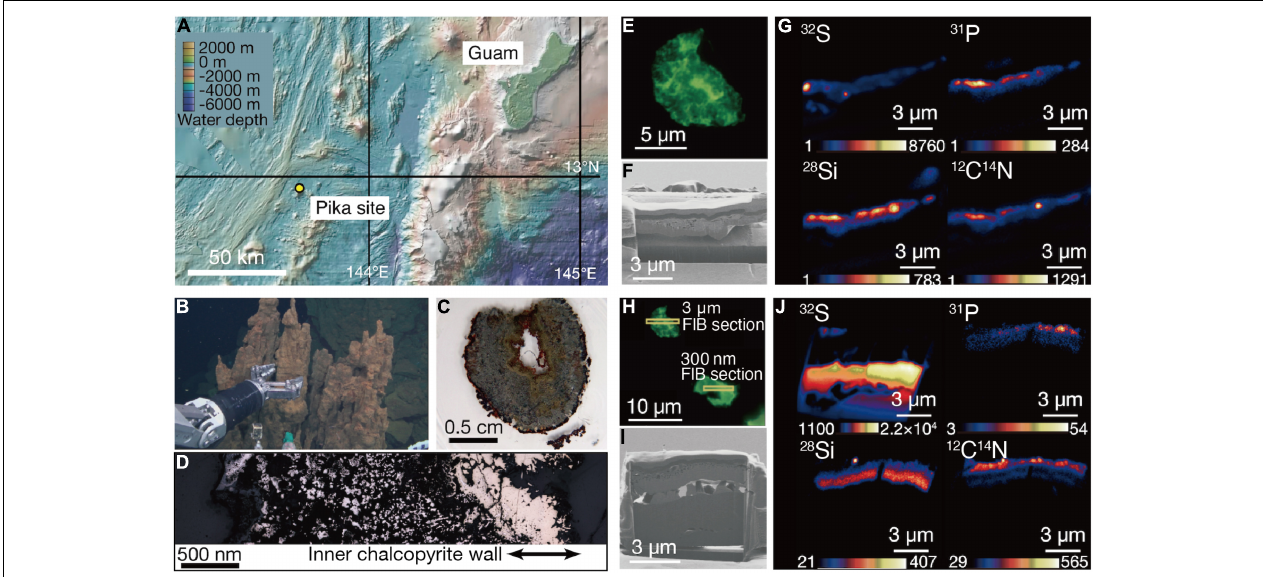
FIGURE 1 | Sampling of an extinct chimney and microbial signal detections. (A) Bathymetric map of the southern Marina trough showing the Pika site and Guam. (B) Photograph showing the extinct chimney sampled by the remotely operated vehicle Hyper Dolphin . (C) Light microscopy image of a thin section from the extinct chimney. (D) Reflection light microscope image of the thin section. The inner chalcopyrite wall is indicated with arrows. (E) Fluorescence microscopy image of a grain boundary with greenish cell-like signals where a 3- µ m thick focused ion beam (FIB) section was fabricated. (F) Ga ion image of a 3- µ m thick FIB section from